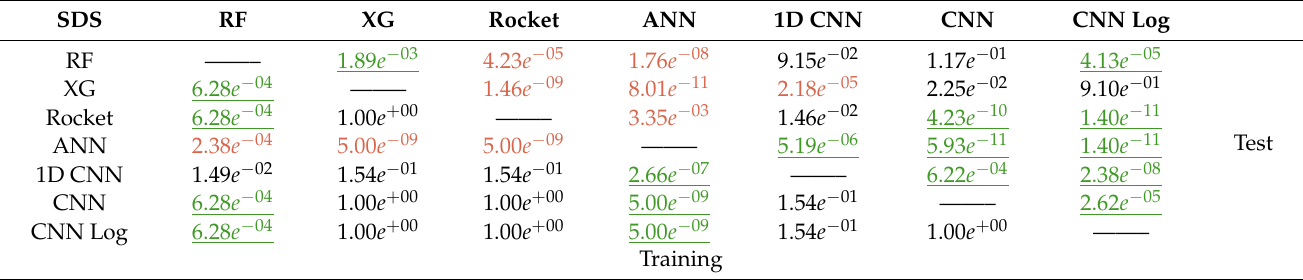
Table A7. Kruskal–Wallis p -values comparing all methods of the SDS concentration prediction task. Above the diagonal, we have the results for the test set, and below for the training set. Significant results ( p < 0.01) are represented in green or red when the method on the left is significantly better or worse,